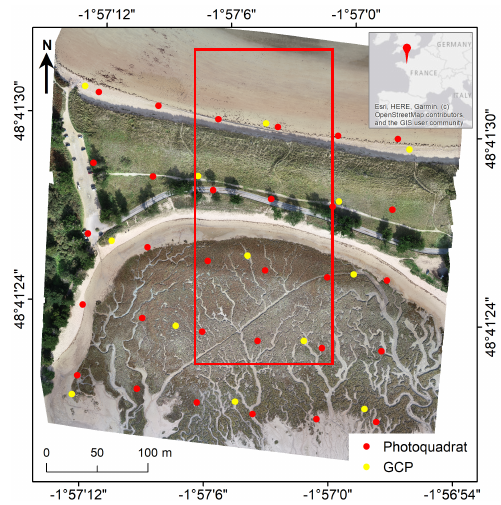
Figure 1. Guimorais’ study site.